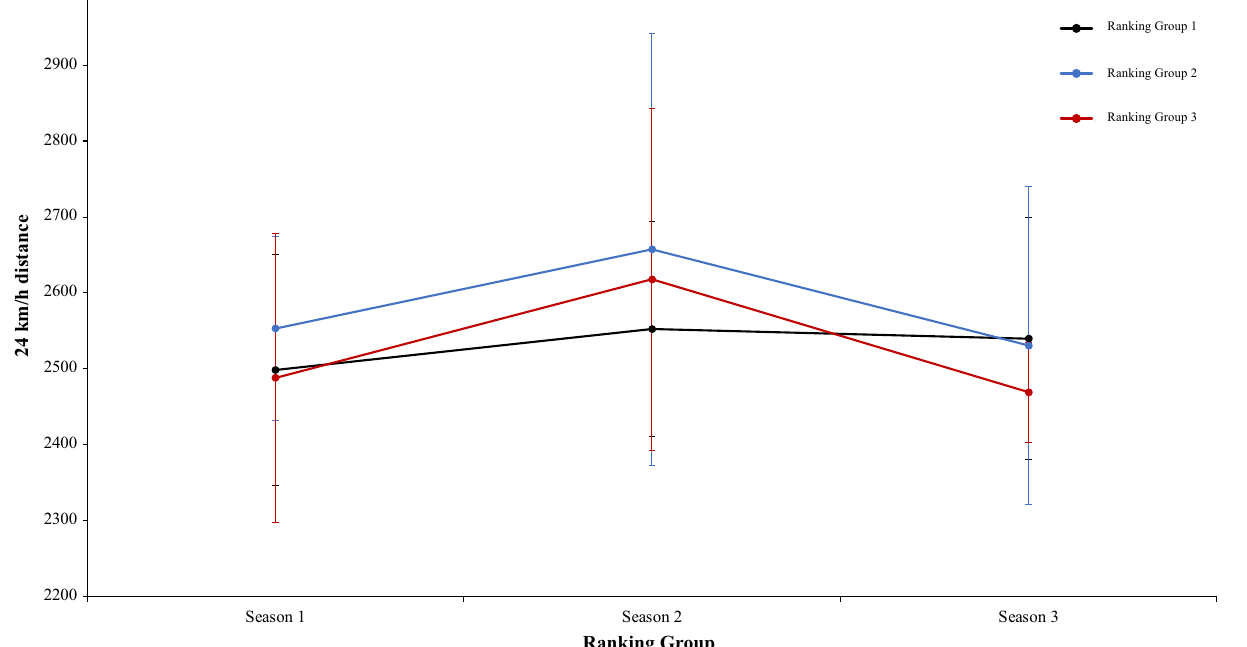
Figure 8. Physical performance. Mean TSD (± SE) as a funtion of Ranking and Season